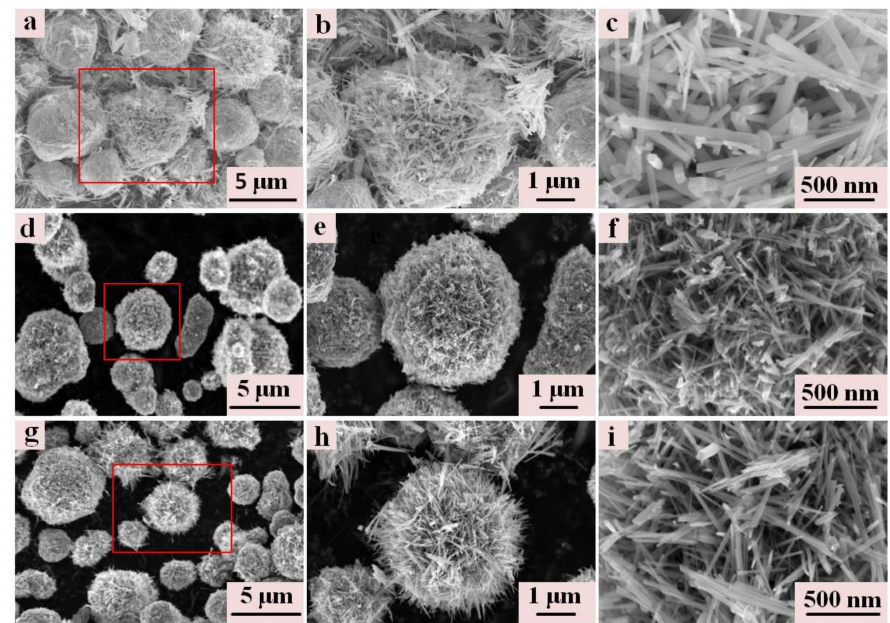
Figure 1. The SEM images of MnO 2 -SM120-12 ( a – c ); MnO 2 -SM120-0.5 ( d – f ); and MnO 2 -SM150-0.5 ( g – i ). The structural characterization of MnO 2 -SM120-12 (green line), MnO 2 -SM120-0.5 (blue line), and MnO 2 -SM150-0.5 (orange line), were carried out and compared by XRD. As shown in these XRD patterns (Figure 2), the diffraction peaks located at the 12.8, 18.1, 25.8, 28.8, 37.5, 42.0, 49.9, 56.9, 60.3, 65.1, 69.7 and 72.7 positions in all three samples belonged to the (110), (200), (220), (310), (211), (301), (411), (431), (521), (002), (541) and (312) facets, respectively. These sharp peaks indicated the